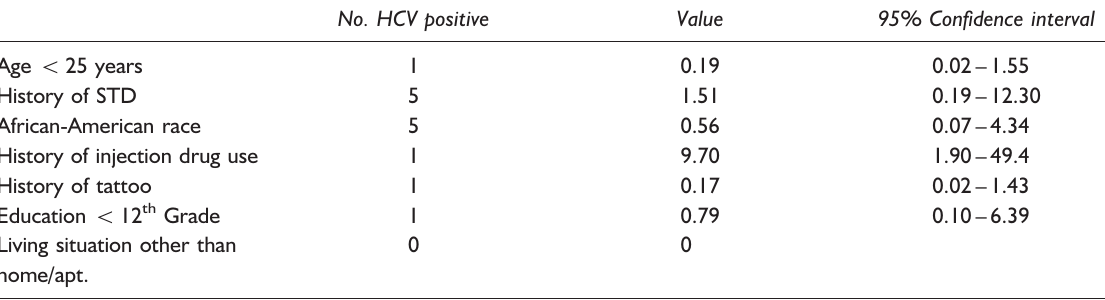
Table 2 Unadjusted relative risks between hepatitis C seropositivity and various risk